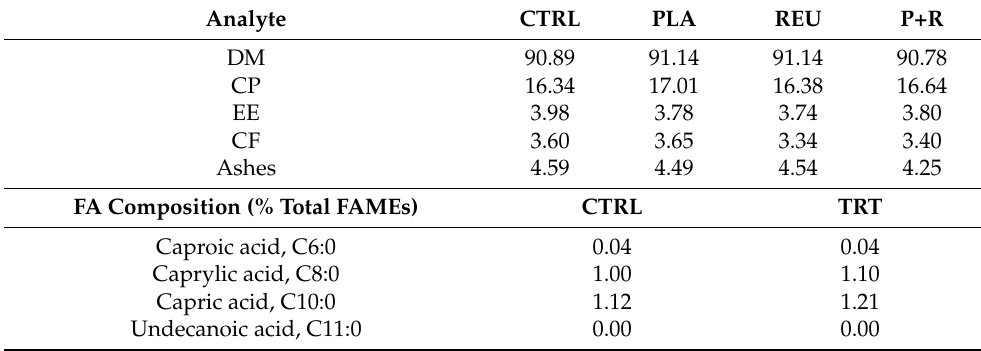
Table 2. Chemical composition of experimental diets divided by control (CTRL) and treatment groups (PLA, REU and